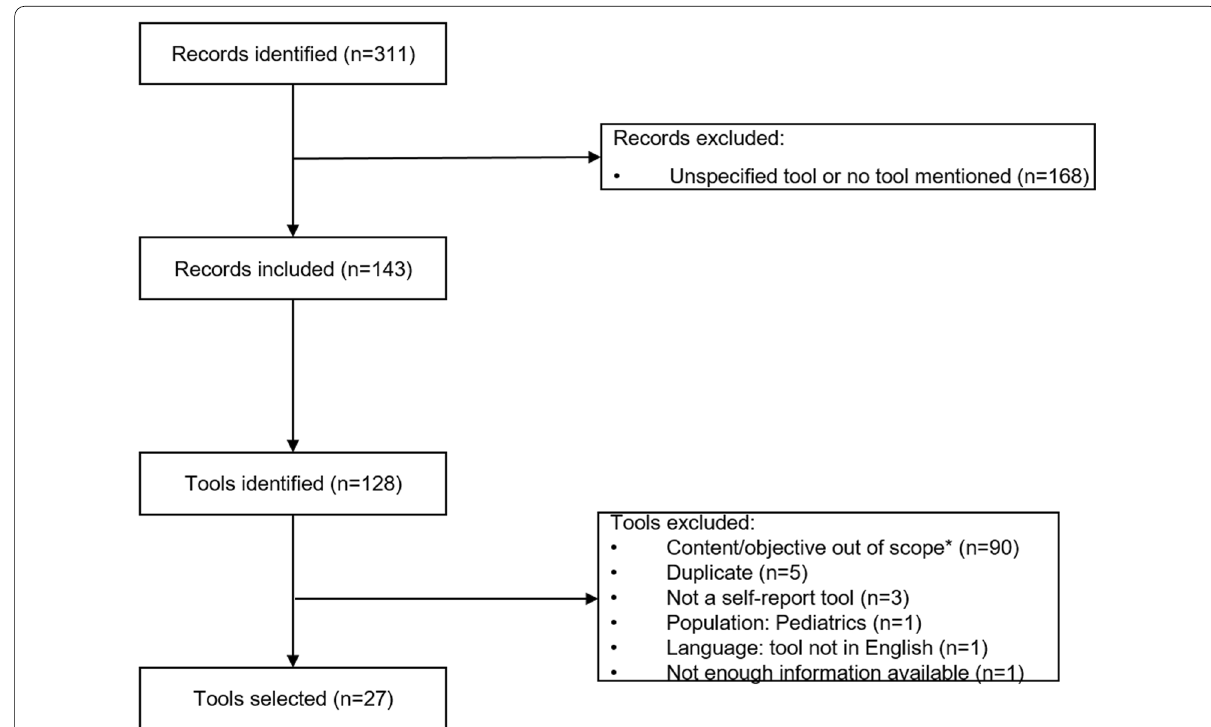
Fig. 2 Selection process of the targeted literature review. *Not related to any of the concepts of interest (i.e., treatment and treatment